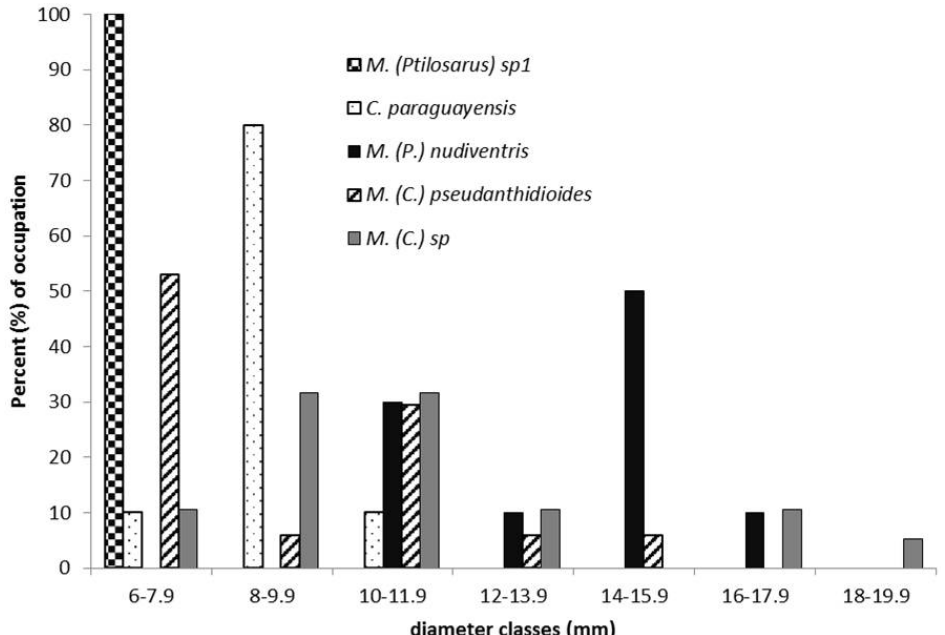
Fig 2 . Percent of occupation of the trap-nests used by Megachilidade bees in the ReBio União, presented in diameter classes